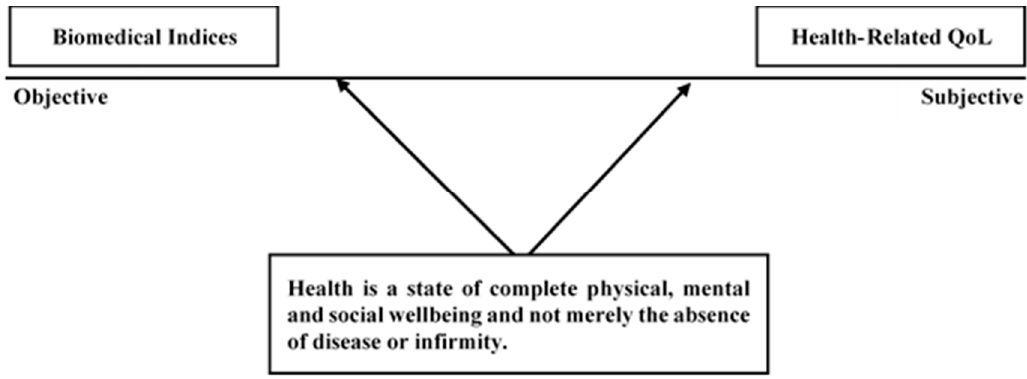
Figure 1. Approaches to health assessments. Subjective evaluations (i.e., HRQOL) capture the wellbeing aspects of health, while objective biomedical measures index the disease and infirmity aspect.